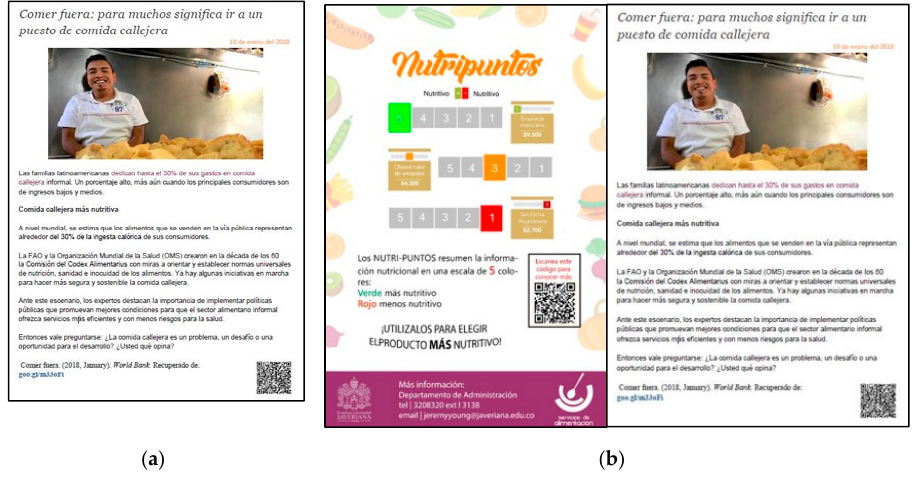
Figure 1. Information placards for control and treatment groups. ( a ) control placard; ( b ) treatment placard.